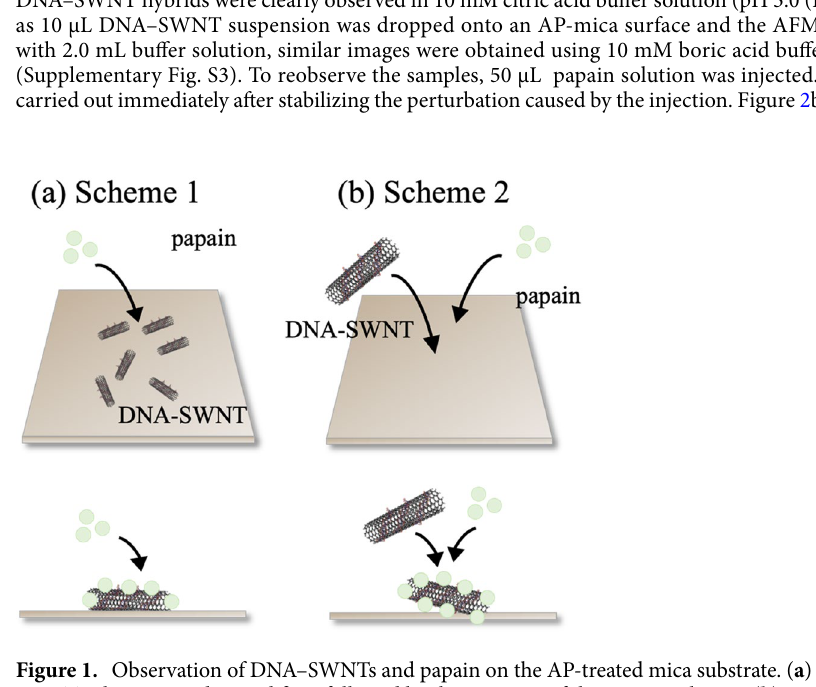
Figure 1. Observation of DNA–SWNTs and papain on the AP-treated mica substrate. ( a ) Scheme 2: DNA– SWNT solution was dropped first, followed by the injection of the papain solution. ( b ) Papain and DNA–SWNT solutions were successively dropped. All schemes were conducted at pH 3.0 and